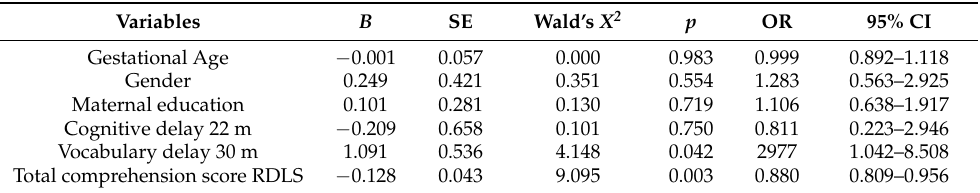
Table 10. Logistic regression analysis: predictors of morphosyntactic production (TSA) delay at 60 months of